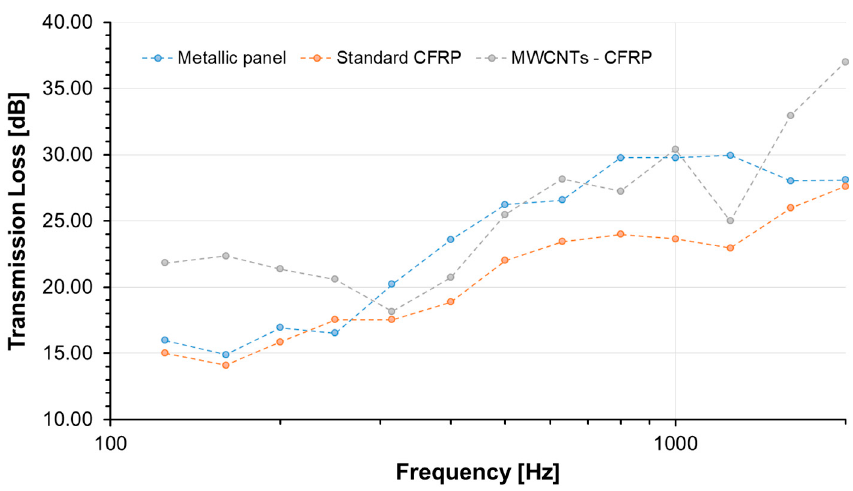
Figure 12. Transmission Loss: 1/3 Octave Bands Centre Frequency.